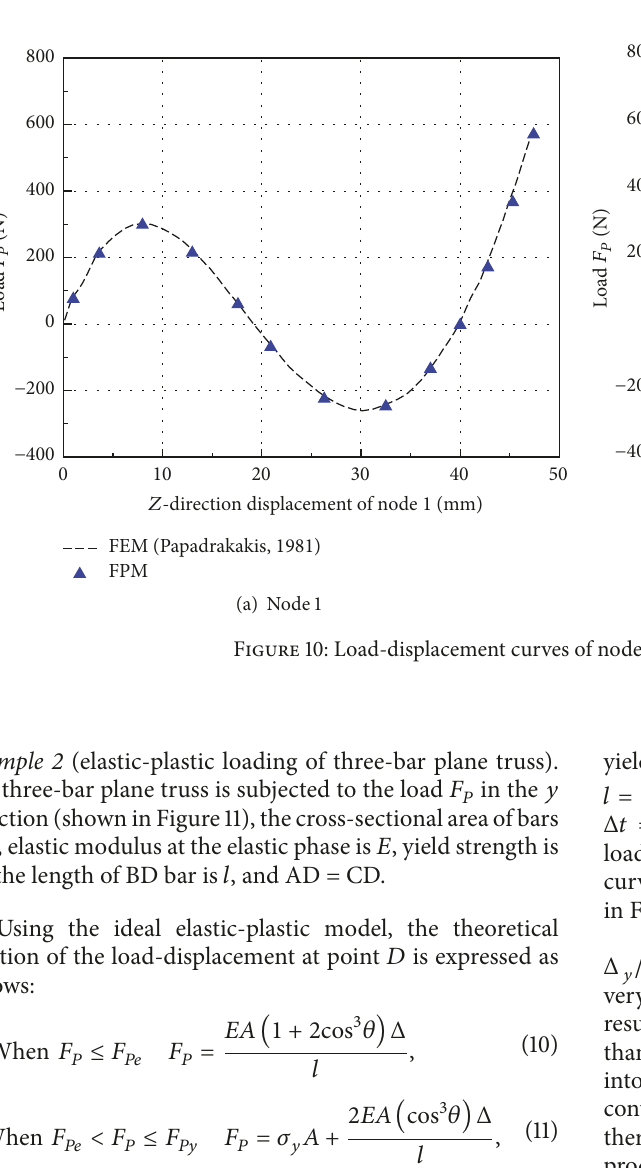
Figure 9: 24-bar star dome geometry and loading.